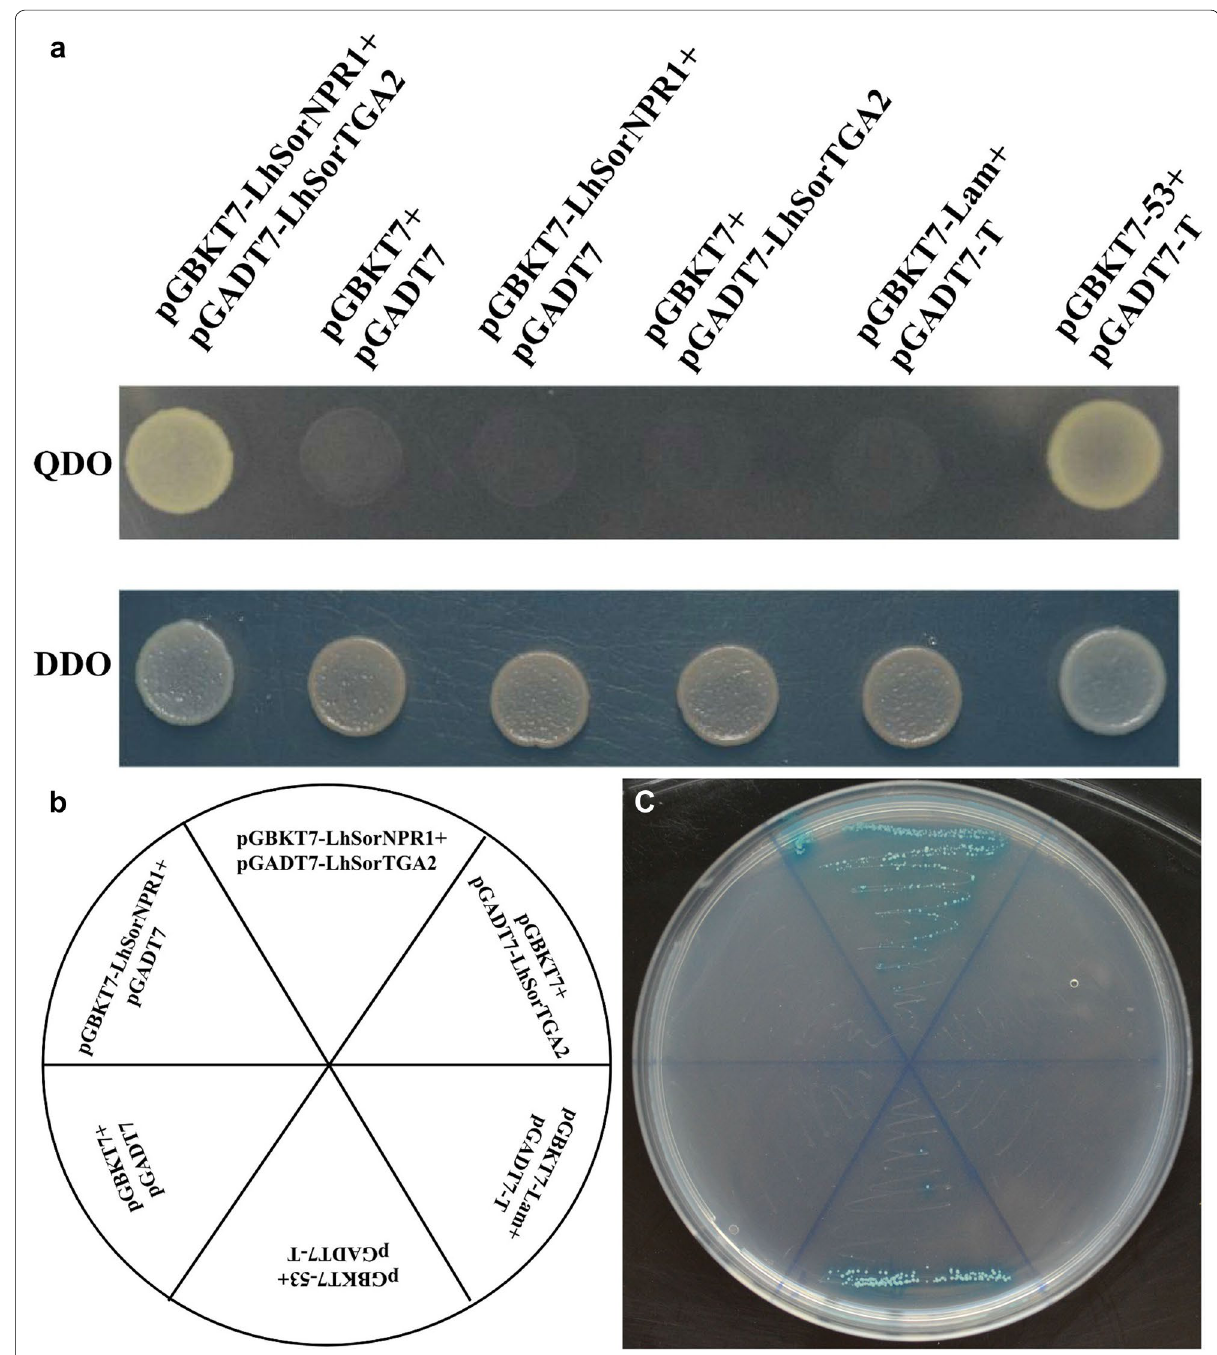
Fig. 4 LhSorNPR1 and LhSorTGA2 protein interaction assessed by the yeast two hybrid assay. a Yeast AH109 cells co-transformed with bait and prey vectors were grown on double dropout (DDO, SD/-Leu/-Trp) and quadruple dropout (QDO, SD/-Ade/-His/-Leu/-Trp) mediums. b The diagram indicates the corresponding co-transformants for the assay in c . c Transformants were streaked on QDO medium supplemented with 40 µg/ml X-α-Gal. pGBKT7-53 and pGADT7-T co-transformant was used as the positive control. Yeast cells co-transformed with pGBKT7 and pGADT7, pGBKT7- LhSorNPR1 and pGADT7, pGBKT7 and pGADT7-LhSorTGA2, or pGBKT7-Lam and pGADT7-T were used as negative